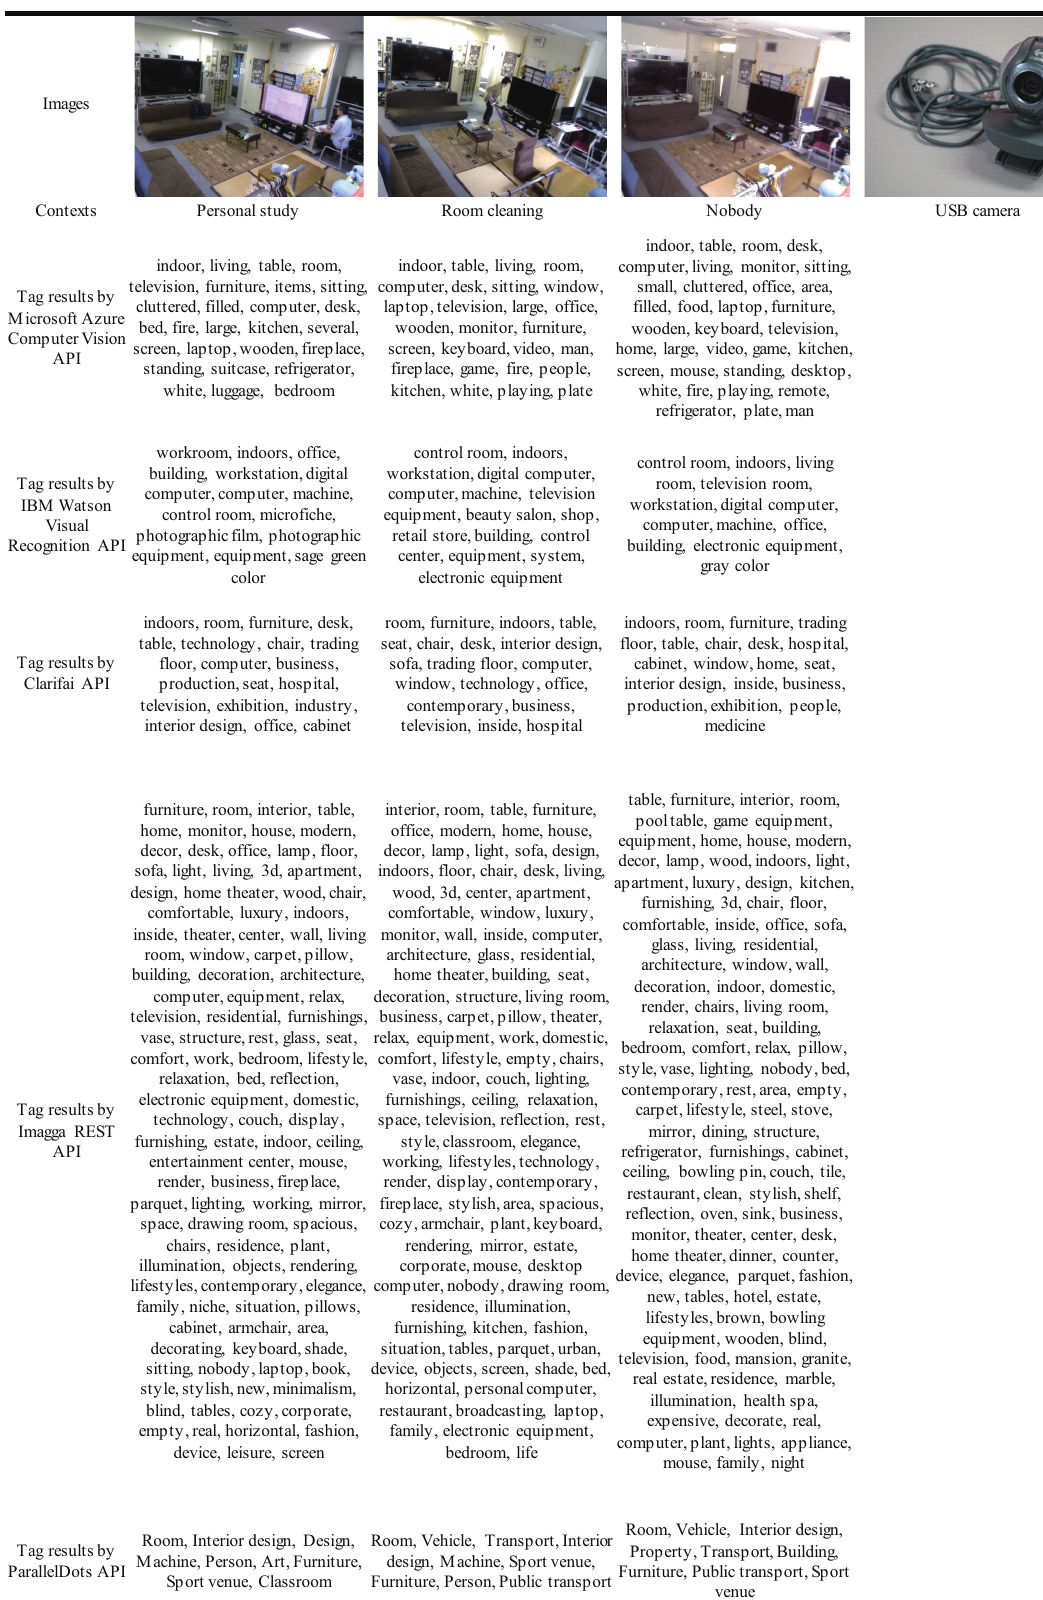
Table 3. The representative images of the other three contexts (including tag results) and USB camera.